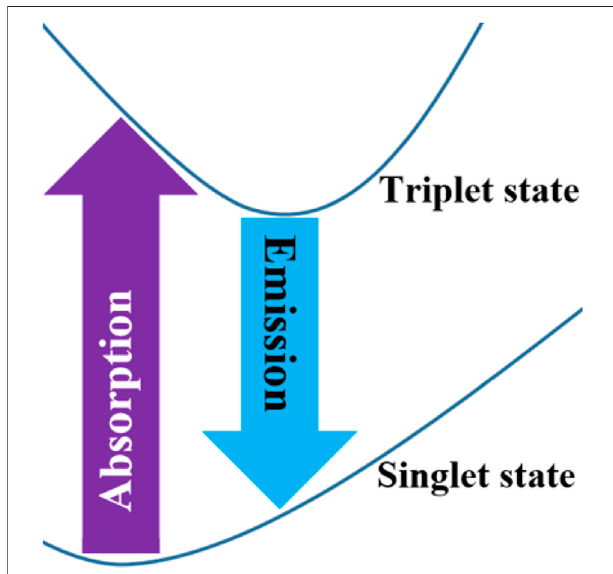
FIGURE 6 | The absorption and emission gaps of the system.